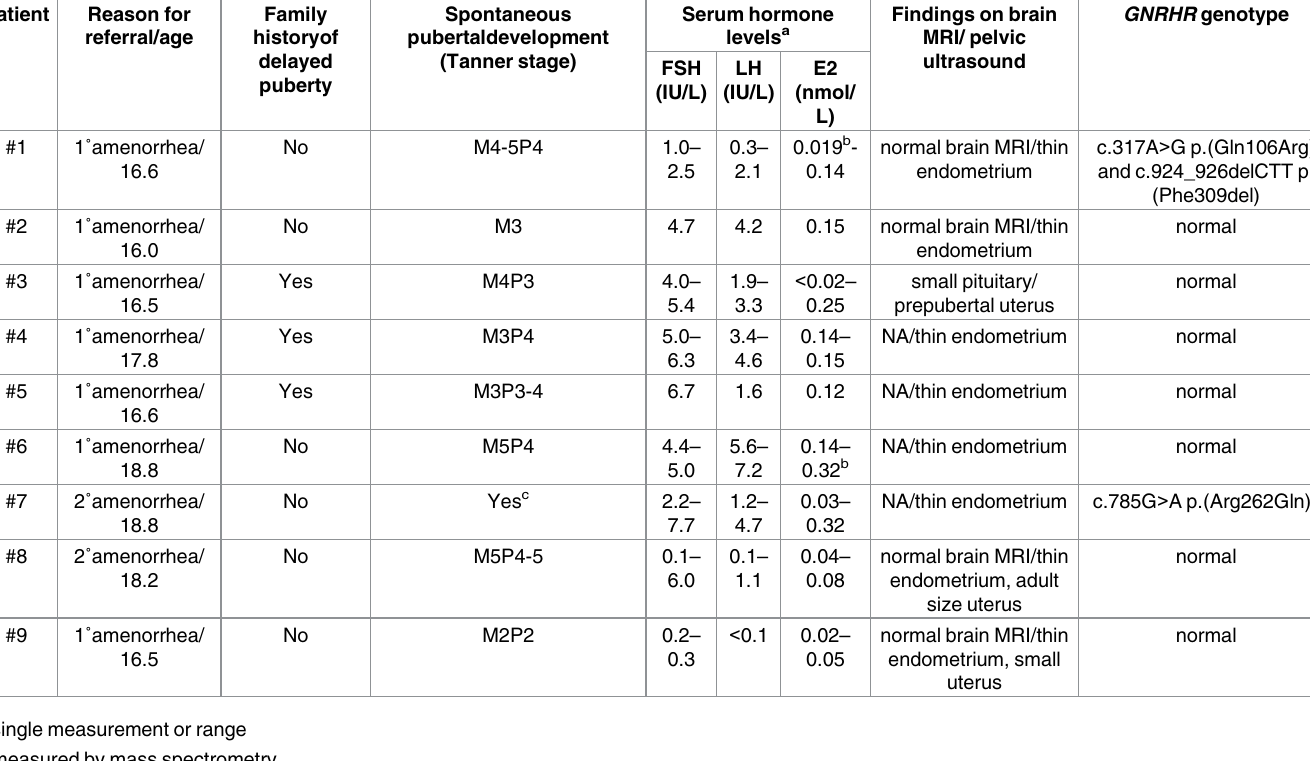
Table 1. Clinical characteristics and GNRHR genotypes in adolescent and young adult females with clinical and biochemical findings suggesting partial gonadotropin